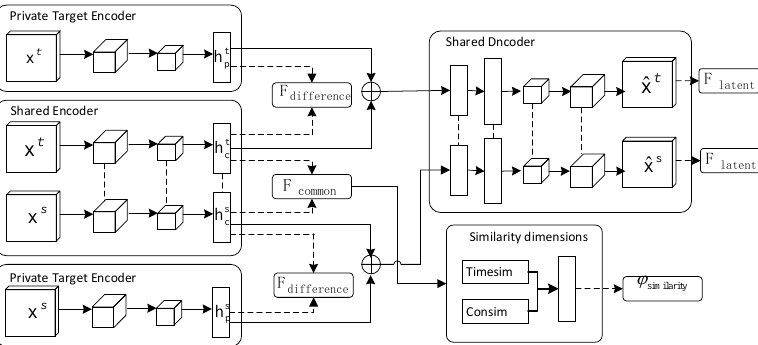
Figure 3. Structure diagram of transfer learning algorithm based on DSN Network.